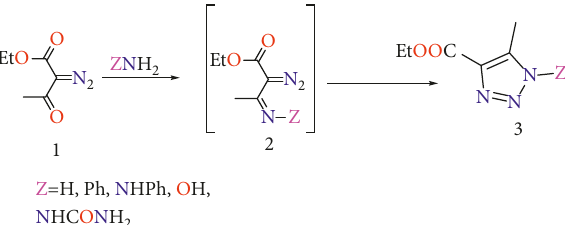
Scheme 4: Synthesis of 1,2,3-Triazoles from 2-Diazo-1,3-Dicarbonyl Compounds with Amines.